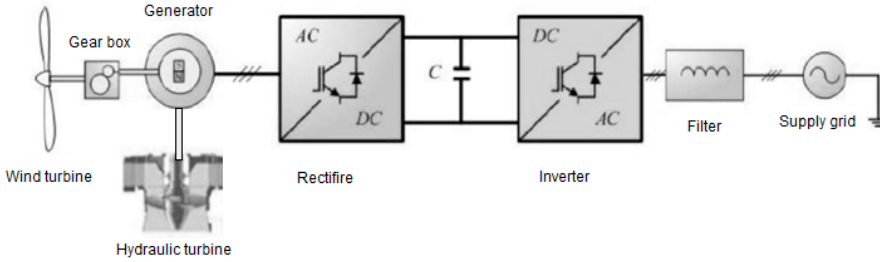
Figure 17. Wind/Hydraulic turbine coupled to permanent magnet synchronous generator.